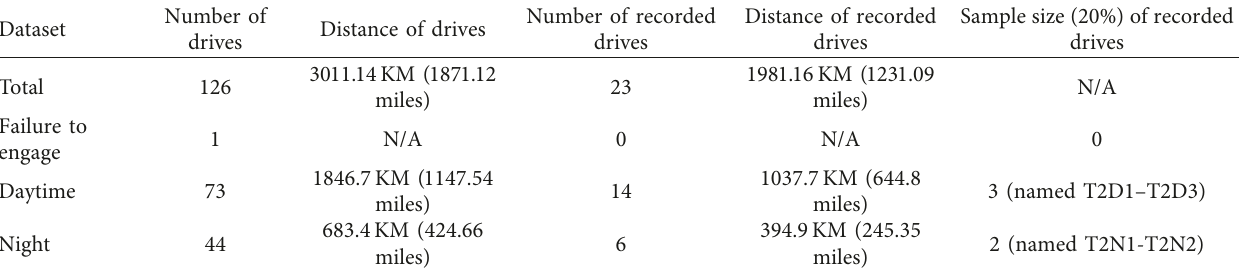
Table 7: Data used in Test2.